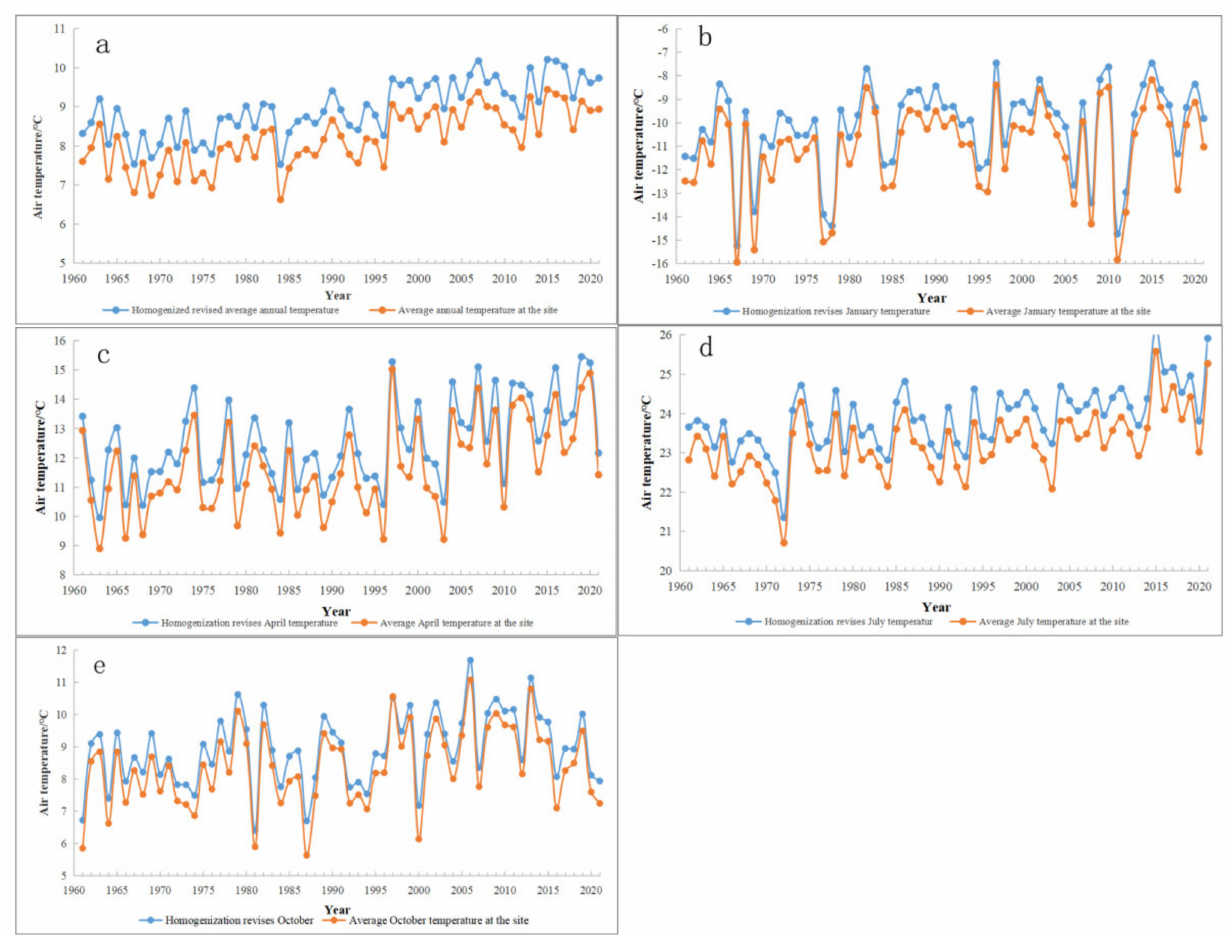
Figure 6. The annual temperatures of the spatially homogenized revised average and equal-weighted average in Xinjiang, 1961 − 2021( a ): Annual; ( b ): January; ( c ): April; ( d ): July; ( e ):